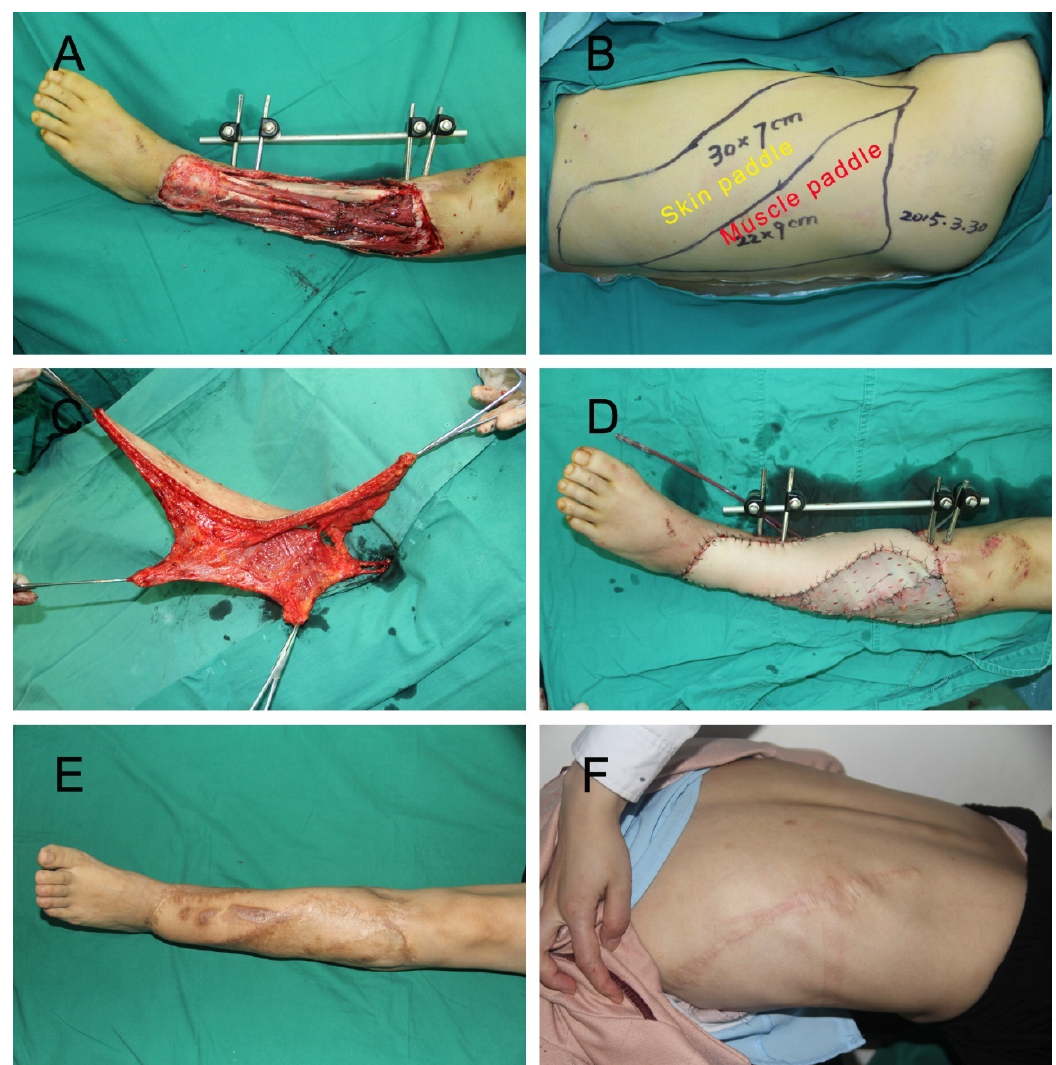
Figure 2. ( A ) A 28-year old female injured in a traffic accident that caused a large soft-tissue defect on the left lower leg. ( B ) Extended LD flap design. ( C ) Harvest of the flap. ( D ) The extended LD flap was used to cover the large defects. The exposed part of the latissimus dorsi muscle flap and remaining lower extremity wounds repaired with split-skin graft. ( E , F ) Recipient and donor site at the 19-month follow-up.